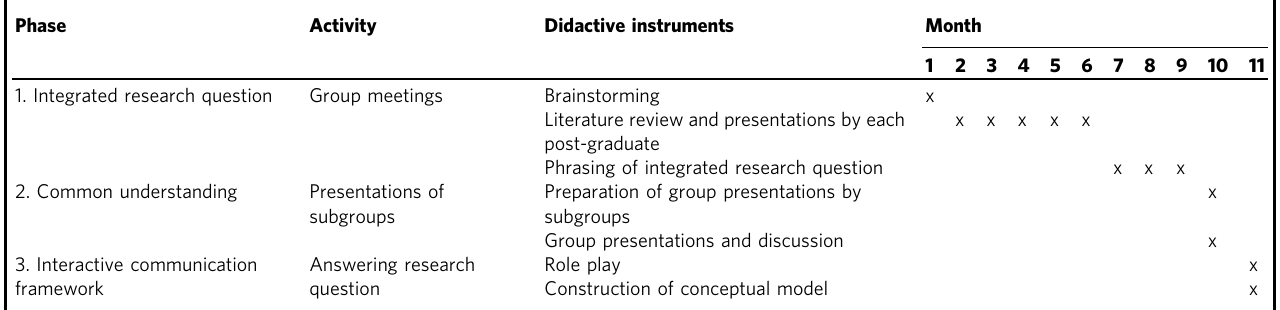
Table 2 Progress of the group project InterWind.